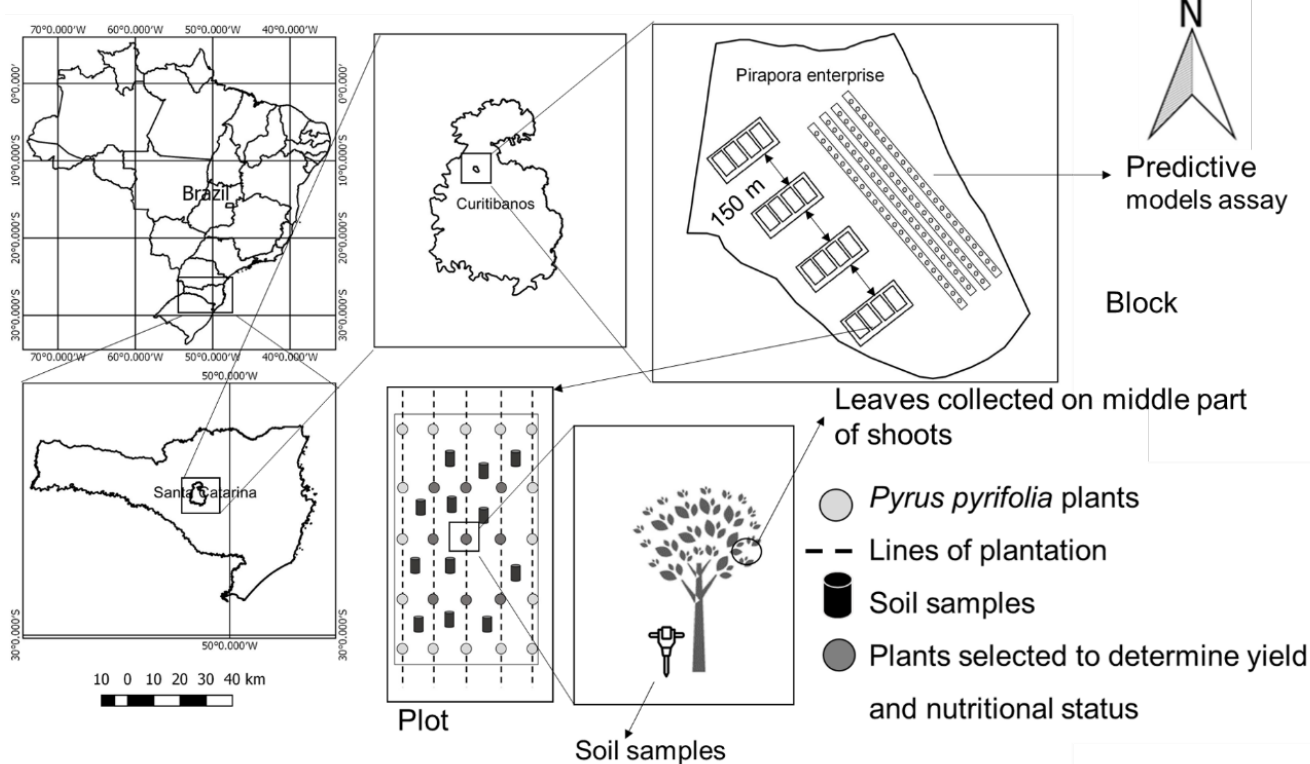
Figure 2. Experimental scheme of our field study inside a 16-year P. pyrifolia field using different organic residues management in a subtropical ecosystem, Curitibanos, Santa Catarina, Southern Brazil.